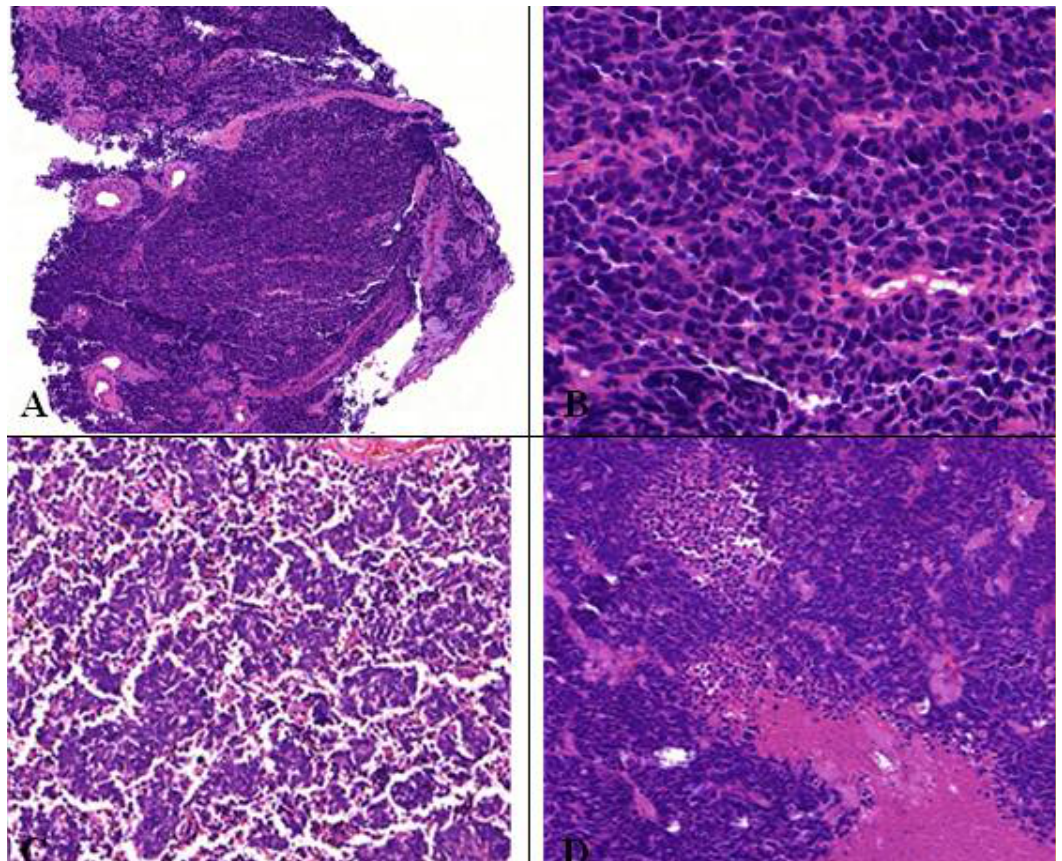
Figure 10. ( A , B ) Microscopic feature of small cell lung cancer infiltrate in a bioptical obtained specimen with high mitotic rate. ( C , D ) Small cell lung cancer in higher magnification with malignant small cells with scant cytoplasm and defined cell